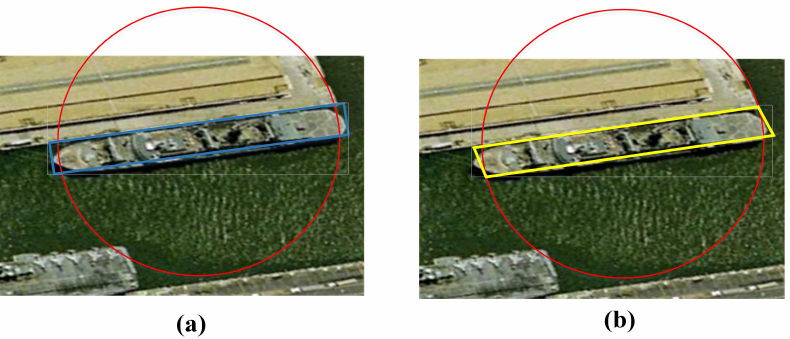
Figure 8. ( a ) The case where the short side of the horizontal rectangle does not intersect the circle. ( b ) The parallelogram obtained by connecting the midpoint and intersection of the short side of the horizontal